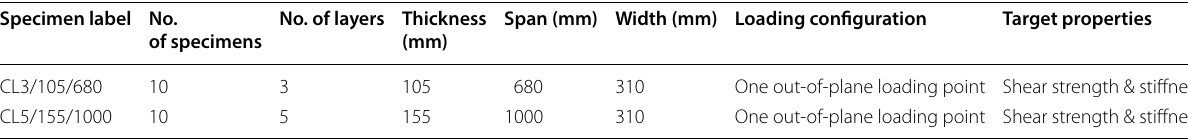
Table 4 Details of CLT shear specimens Specimen label No. No. of layers Thickness of specimens